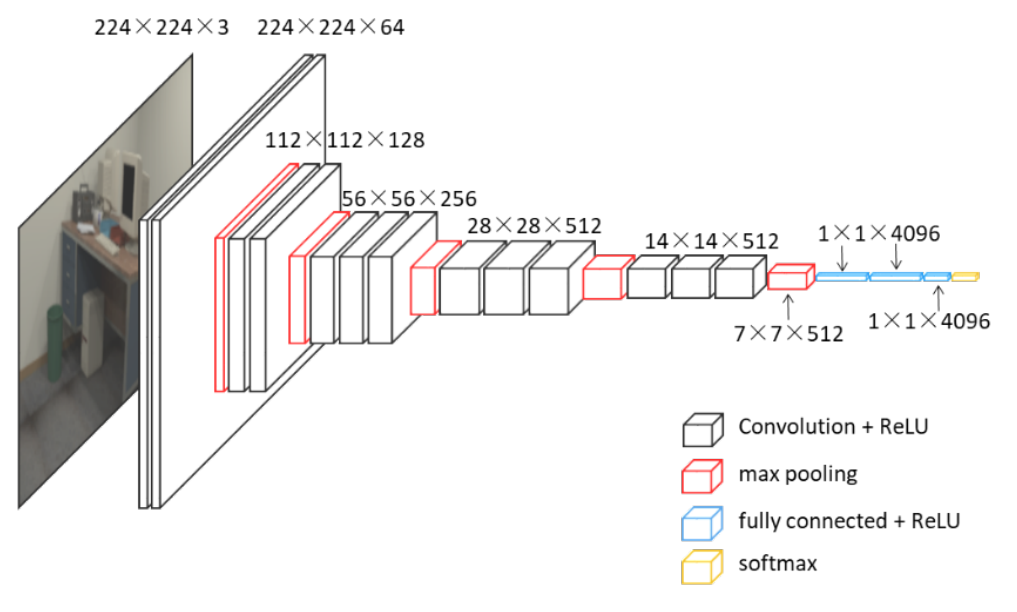
Figure 2. Architecture of VGG16.